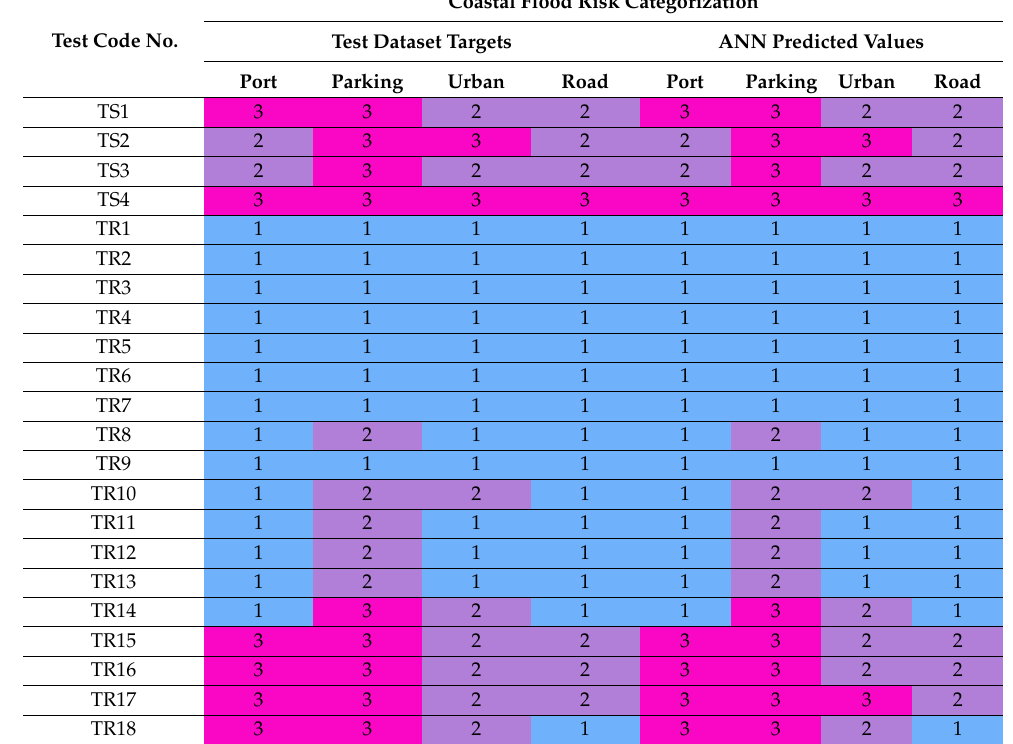
Table 4. ANN predictions of coastal flood-risk level for randomly selected sea-state events.